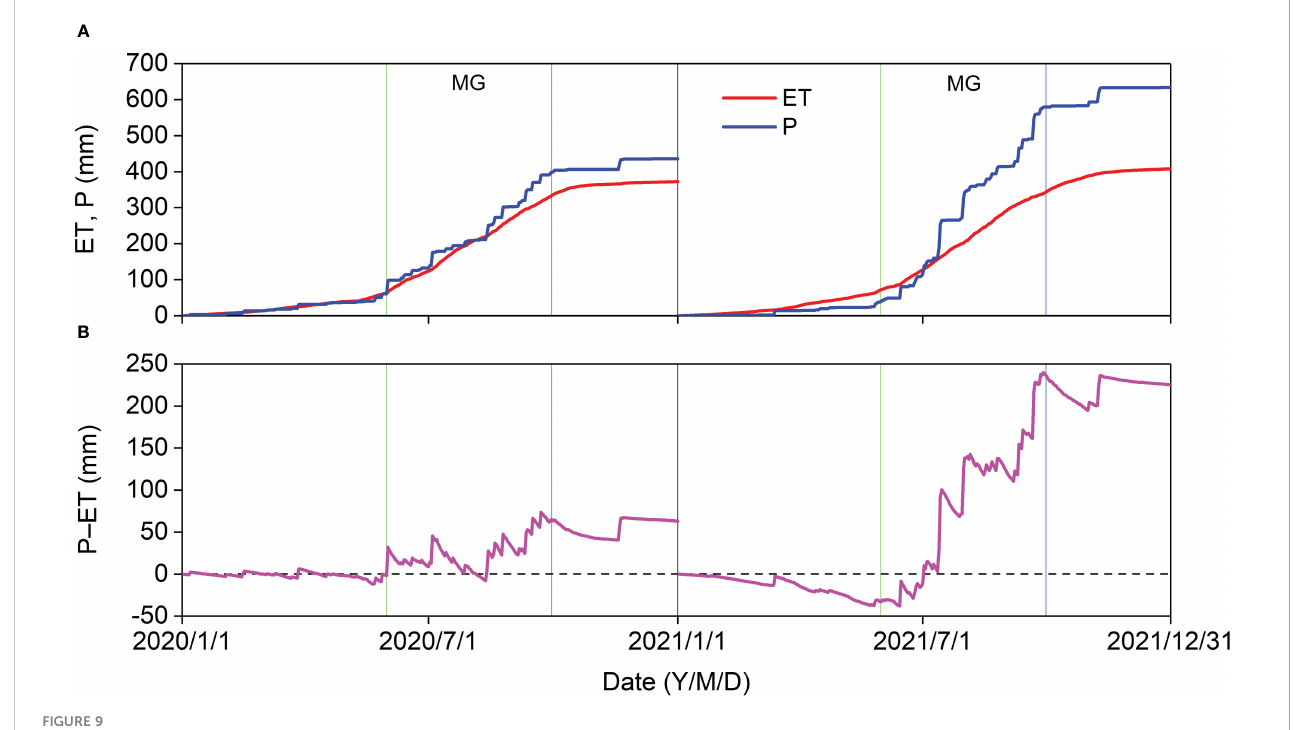
FIGURE 9 Cumulative (A) ET, P, and (B) P – ET in 2020 and 2021.